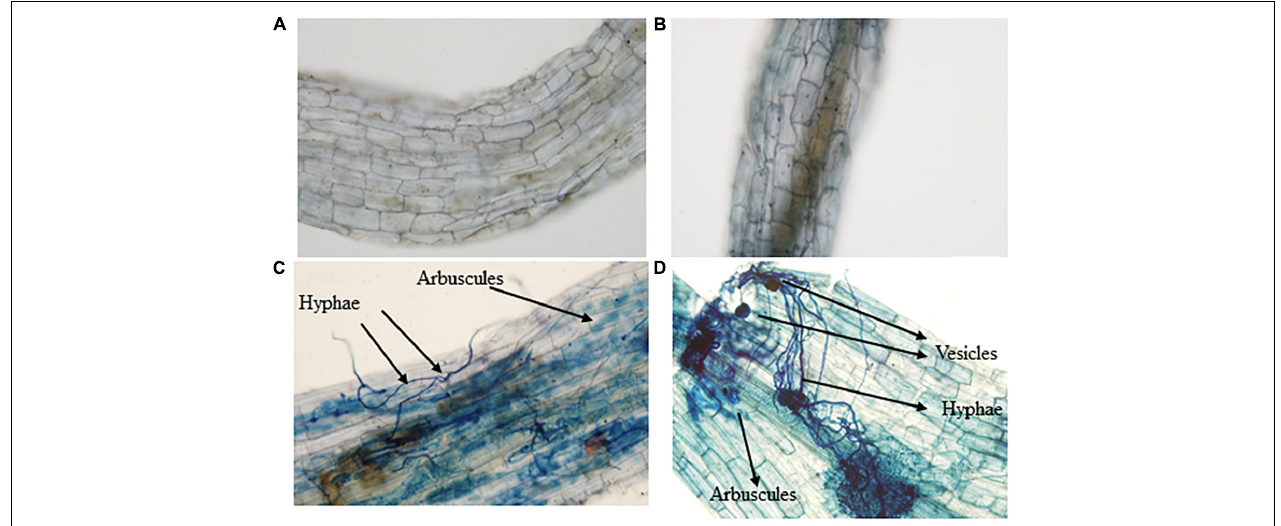
FIGURE 2 | Microscopic pictures of eggplant roots and Arbuscular mycorrhizal fungal colonization. (A) Control plants’ roots, (B) dry raw garlic stalk roots, (C) arbuscular mycorrhizal fungal-inoculated plant roots, and (D) combination of Arbuscular mycorrhizal fungal and dry raw garlic stalk.